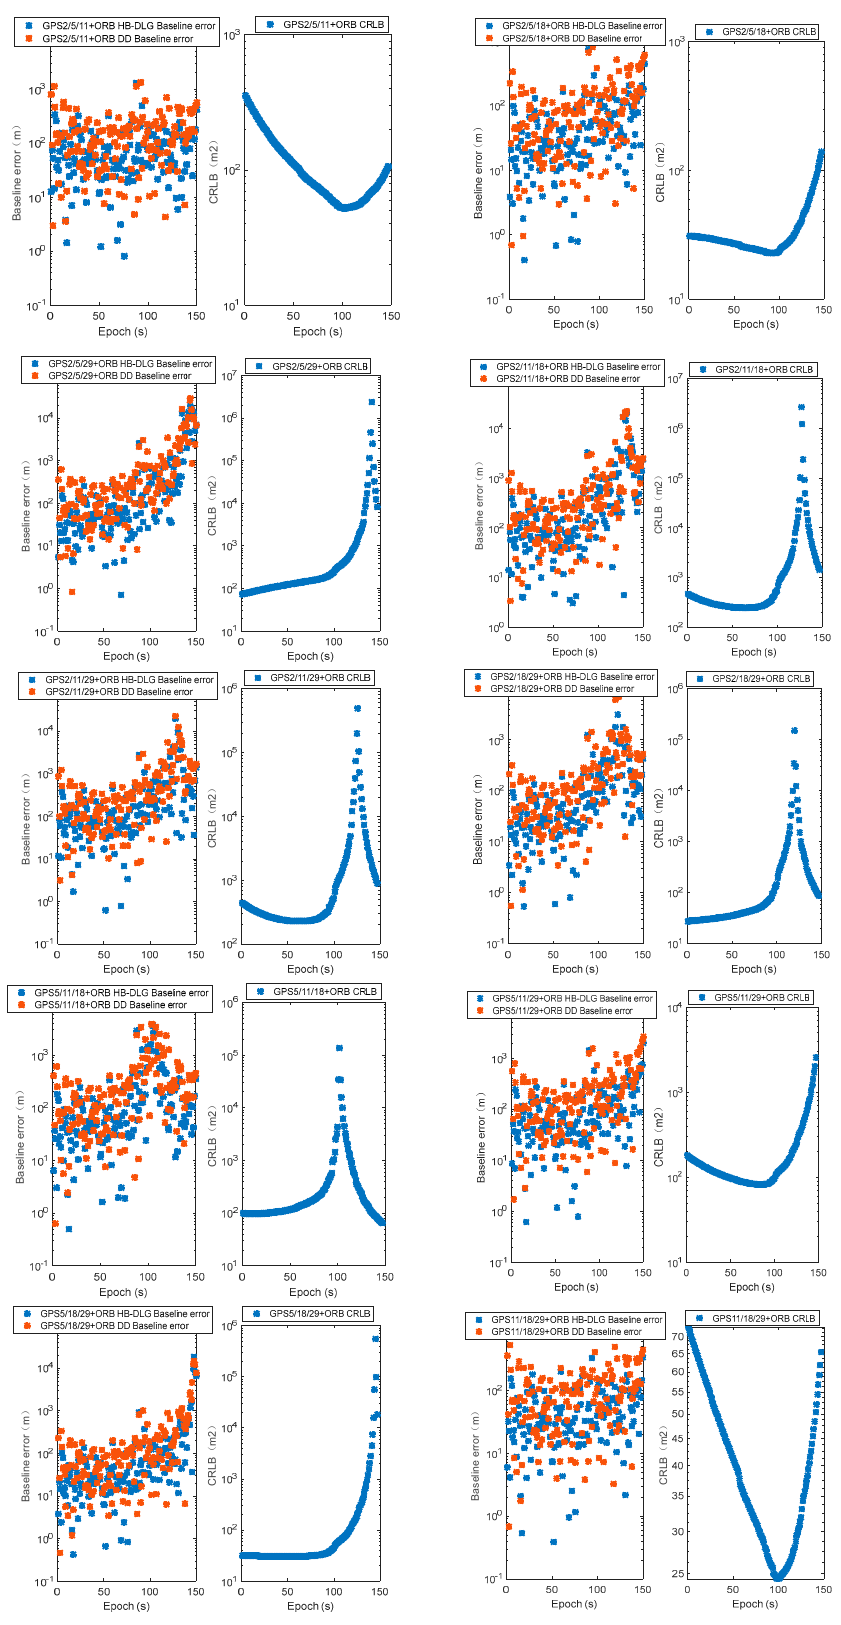
Figure 11. Baseline errors and CRLB in single-epoch for different 3 GPS+2 Orbcomm satellite combinations.